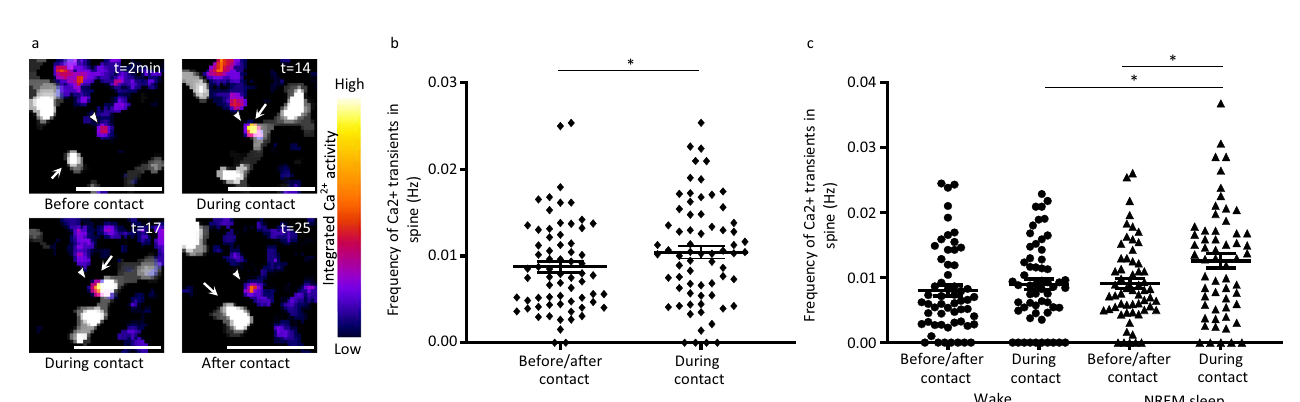
Fig. 6 | Activity during wake exerts positive attraction towards microglial processes. a Color-coded cumulative projection of microglial processes around one spine over4.2-minepisodes of wake and sleep showing microglialdistribution withregardstospinesduringthevigilancestages.Thebrightnessandcontrastwere adjustedfor visualization purposes. Scale bar=10 µ m. Representative imagesfrom the analysis present in Fig. 6c, replicated for >15 episodes of wake or sleep. b Pro- portionofcontactedspinesbymicroglialprocessesduringindividual4.2-minwake and sleep episodes ( n =68 spines from fi ve mice, Wilcoxon test, two-tailed, p=0.625). c Cumulativedistributionofthedistancebetweentheclosestmicroglial process with spines during wake and sleep episodes (Kolmogorov-Smirnov test, two-tailed,**** p <0.0001). d Percentageoftimespentbythespineincontactwitha microglial process during wake and sleep ( n =68 spines from fi ve mice, paired t- test, two-tailed, * p =0.047). e Selected frames showing the minimal distances (yellow line) and maximal distances (purple lines) between the closest microglial processes and a spine active during wake (upper panel) and a spine active during sleep (lower panel). The brightness and contrast were adjusted for visualization purposes. Scale bar=10 µ m. Representative images from the analysis present in